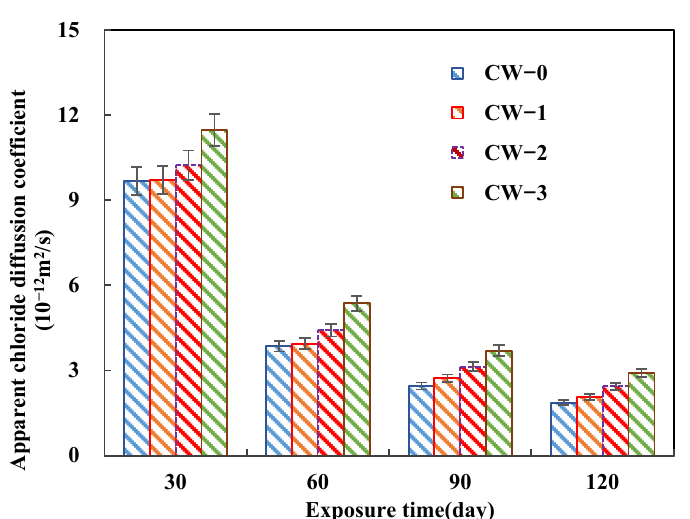
Figure 7. Variations of apparent chloride diffusion coefficient of ECC with different crack widths .